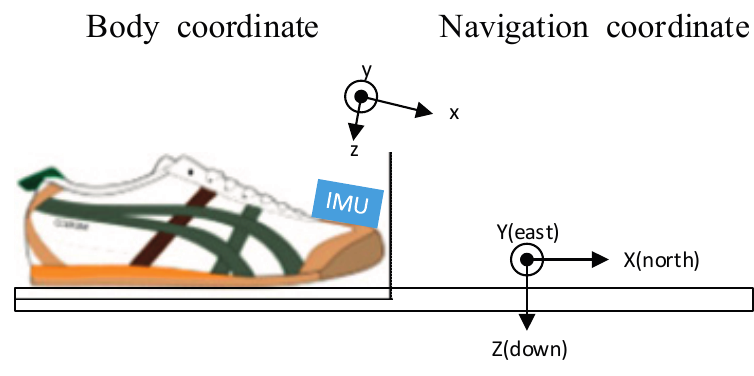
Figure 2. IMU installation mode and the relationship between body coordinate and navigation